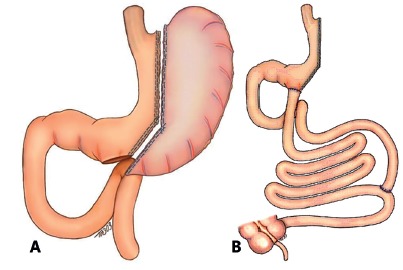
A) Vertical gastrectomy (sleeve); B) gastroentero anastomoses